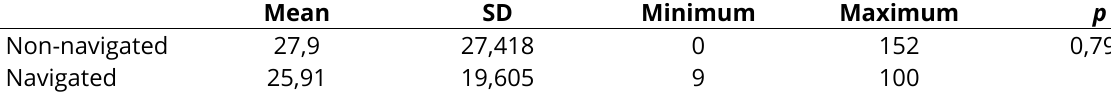
Table 2. Time from first consultation to surgery in days (N=71).